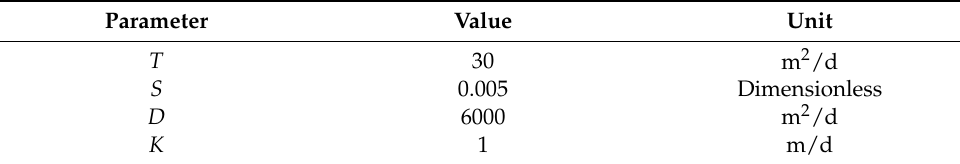
Table 3. Calculation parameters of water level fluctuation of confined